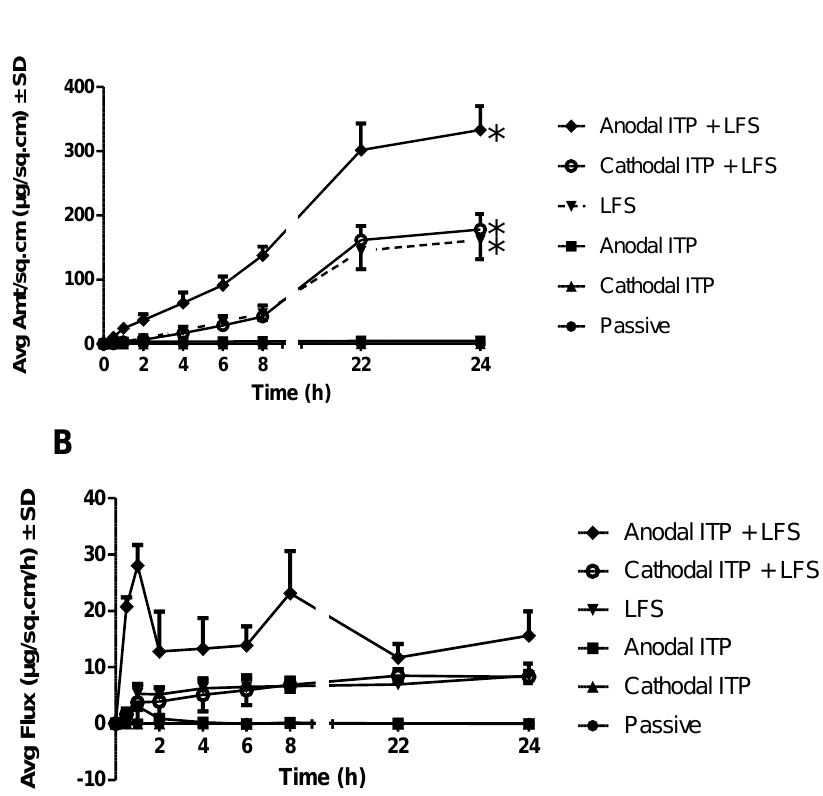
Figure 4. ( A ) Average cumulative amount and ( B ) flux of methotrexate (MTX) delivered through untreated, ITP, and sonophoresis-treated dermatomed human cadaver skin (* indicated statistical difference from the passive group, mean ± SD, n = 4, p < 0.05). Table 2. Transdermal delivery, lag time, flux, permeability coefficient, and steady-state plasma concentration of in vitro permeation of MTX though dermatomed human cadaver skin (mean ± SD, n = 4).